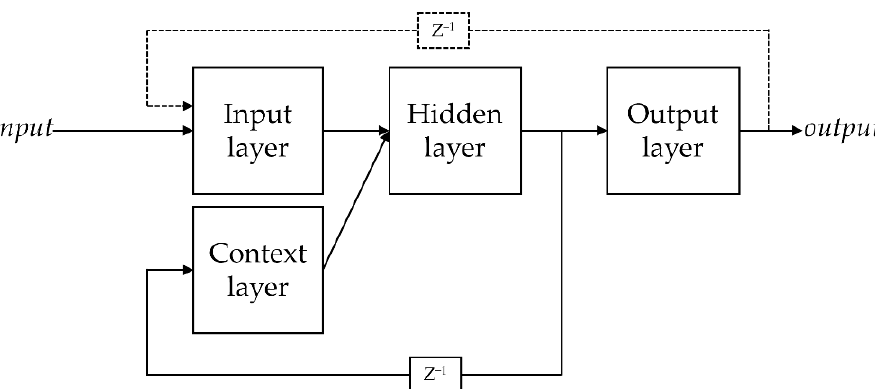
Figure 1. Proposed sensorless permanent magnet synchronous motor field-oriented control (PMSM- FOC) architecture.